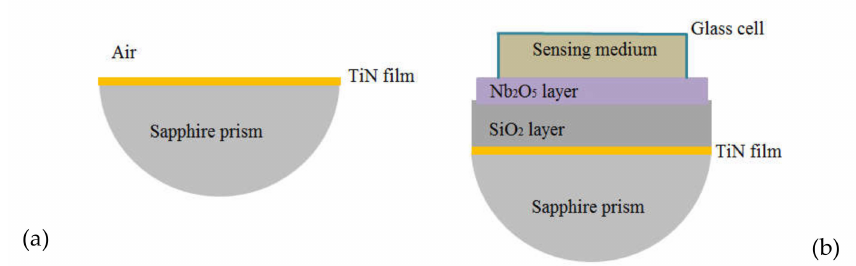
Figure 4. Schematics of ( a ) D-shaped sapphire prism coated with a thin film of titanium nitride and ( b ) prototype of a high sensitivity